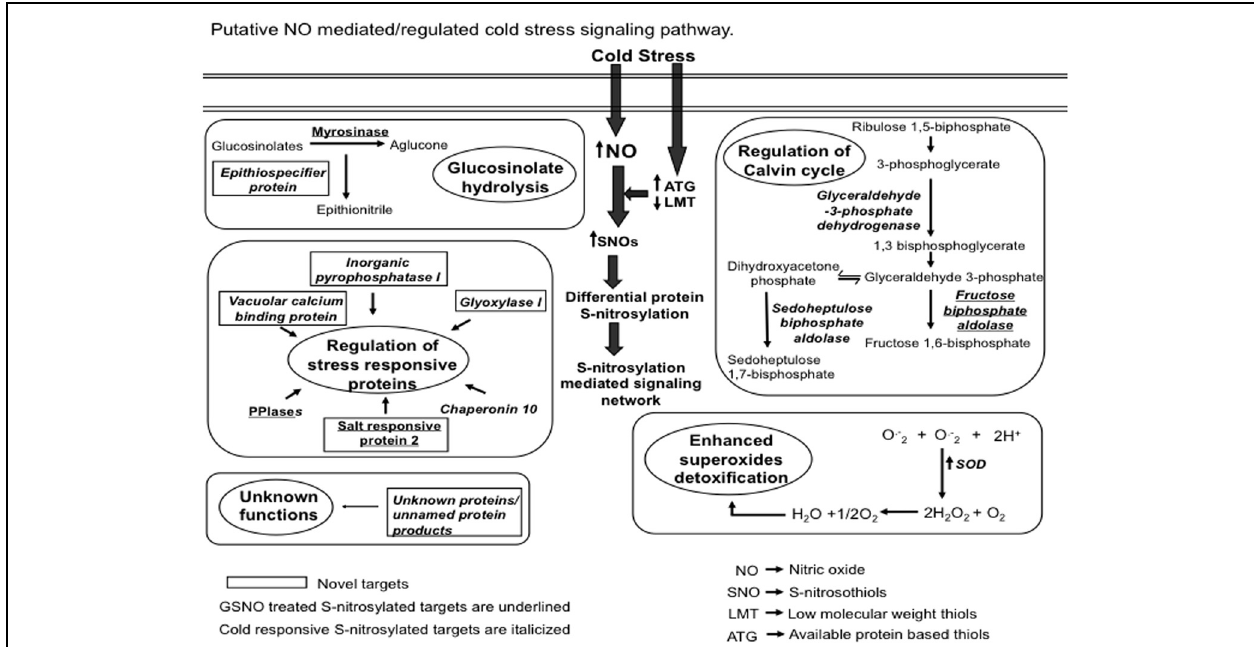
FIGURE 8 | A proposed model showing the S-nitrosylation mediated cold stress signaling. Cold stress increased nitric oxide (NO) production. This increased NO reacts with low molecular weight thiols (LMT) such as glutathione to produce S-nitrosoglutathione (GSNO). Available thiol groups (ATGs) also showed an increase in response to the cold stress. GSNO reacts with these ATGs to produce S-nitrosothiols (SNOs). Increased SNOs promote the S-nitrosylation of constitutive as well as the regulatory proteins. S-nitrosylation of superoxide dismutase (SOD) reduces the